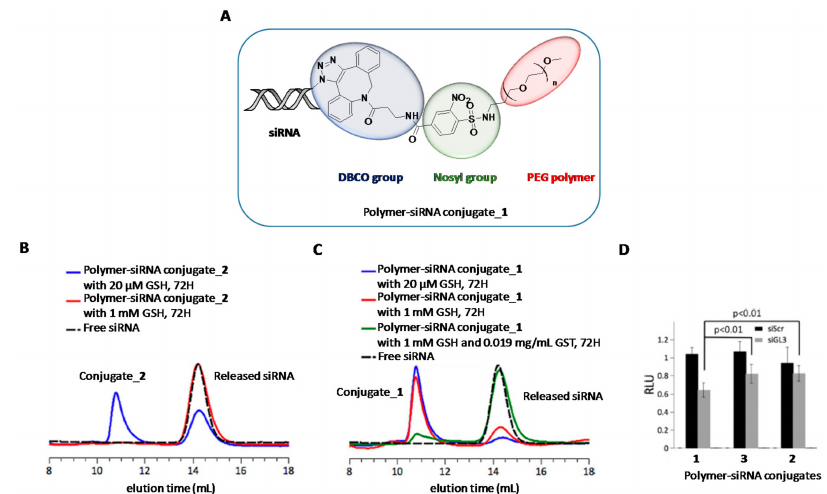
Figure 3. ( A ) Chemical structure of polymer-siRNA conjugate_ 1 . ( B and C ) Polymer-siRNA conjugate behaviours under extracellular and intracellular environments. SiRNA conjugate containing a PEG disulphide group (conjugate_ 2 ) liberated a siRNA molecule under extracellular conditions ( B ) whereas the nosyl group (conjugate_ 1 ) was able to liberate efficiently a siRNA molecule under intracellular conditions (combination of GSH and GST). (D) Gene silencing studies in the presence of lipofectamine in which shows the efficiency of conjugate_ 1 (containing the reducible nosyl group) to reduce significantly the production of luciferase. Adapted with permission from ref. [89]. Copyright 2017, Royal Society of